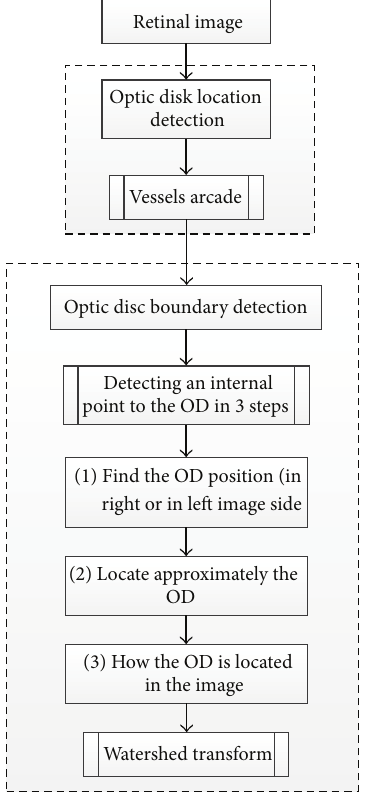
Figure 7: Flowchart for algorithm proposed in